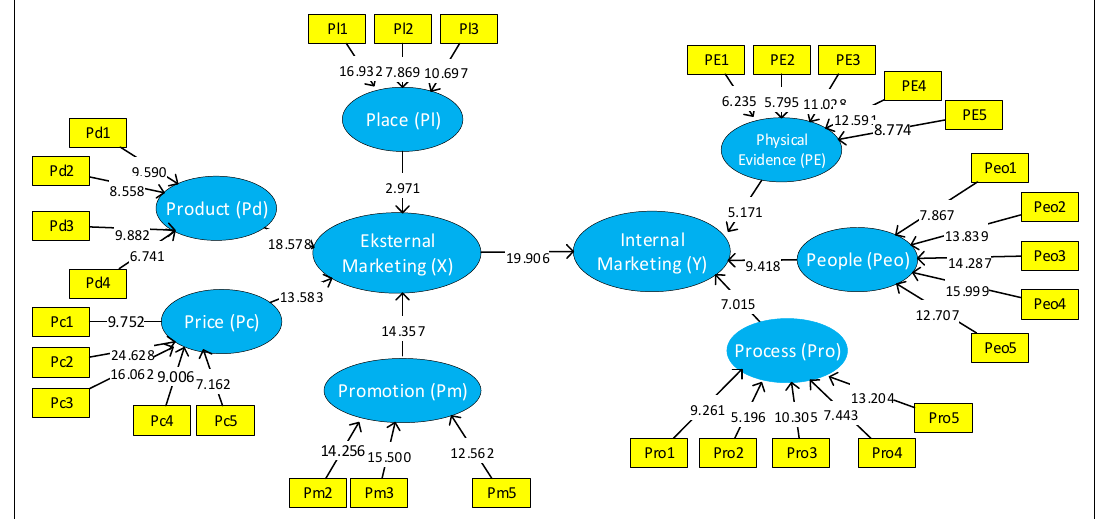
Fig. 4. T-statistics of the indicators and beta